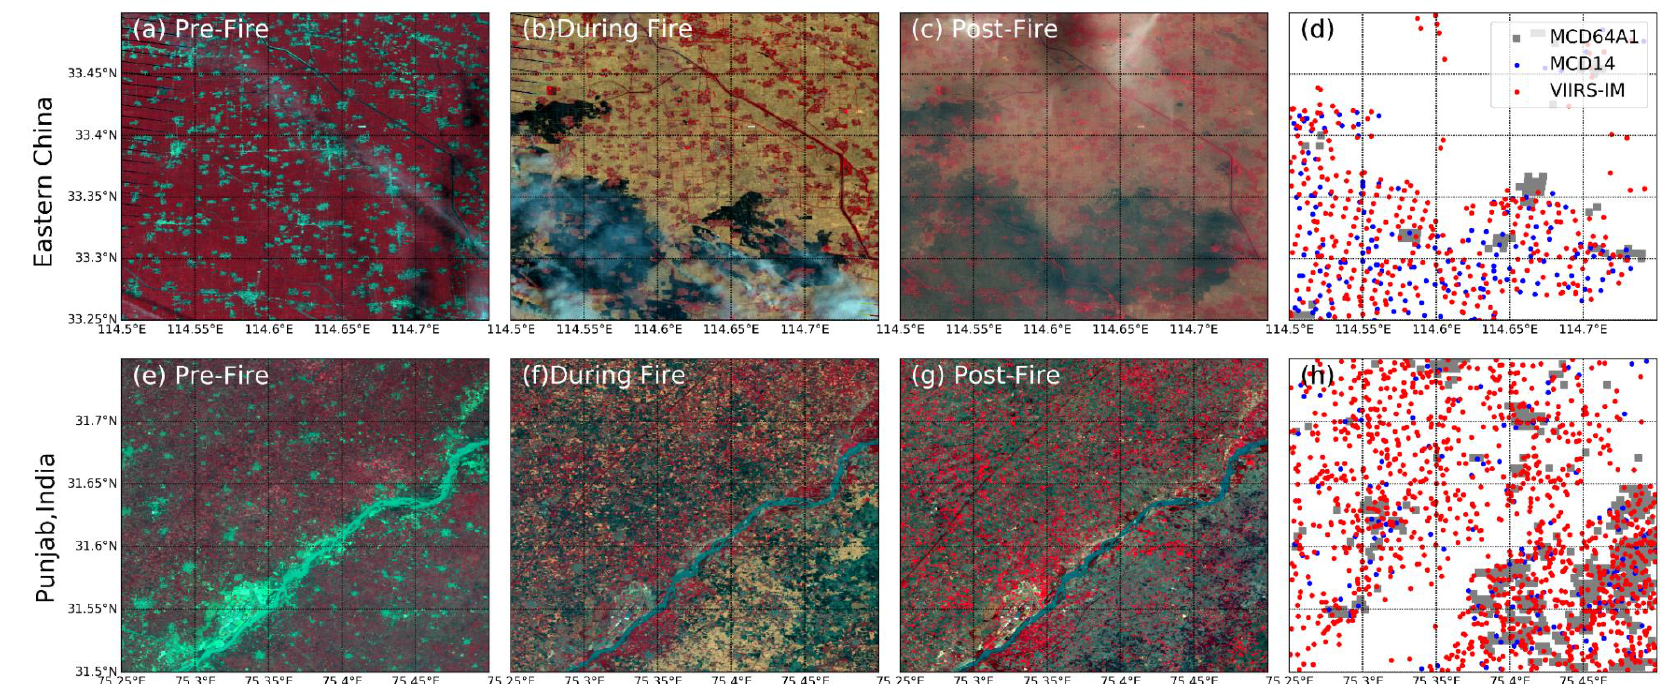
Figure 8. Fire-relevant data covering a 0.25° GFED grid cell in ( top row ) eastern China (centred at 33.375° N, 114.625° E), and ( bottom row ) the Punjab (northwestern India, centred at 31.625° N, 75.375° E). ( a – c ) show Landsat NIR false colour composites taken respectively before (24 April 2015), during (11 June 2015) and after (19 June 2015) the fire activity in eastern China, and ( e – g ) before (24 September 2016), during (26 October 2016) and after (27 November 2016) the fire activity in the Punjab, India. For comparison, ( d , h ) show the mapped fire activity respectively reported in these same two areas during the same period by the 500 m MODIS MCD64A1 burned area (BA) products, the 1 km MCD14 active fire (AF) product, and the 375 m VIIRS-IM AF product. Compared to the evidence from Landsat, eastern China appears to have large areas of burning missing in the MCD64A1 BA product, whereas in the Punjab the MCD64A1 product appears to do relatively well south of the river that bisects the grid cell from southwest to northeast, but less so north of the river where the small agricultural fires appear more fragmented in the Landsat imagery.